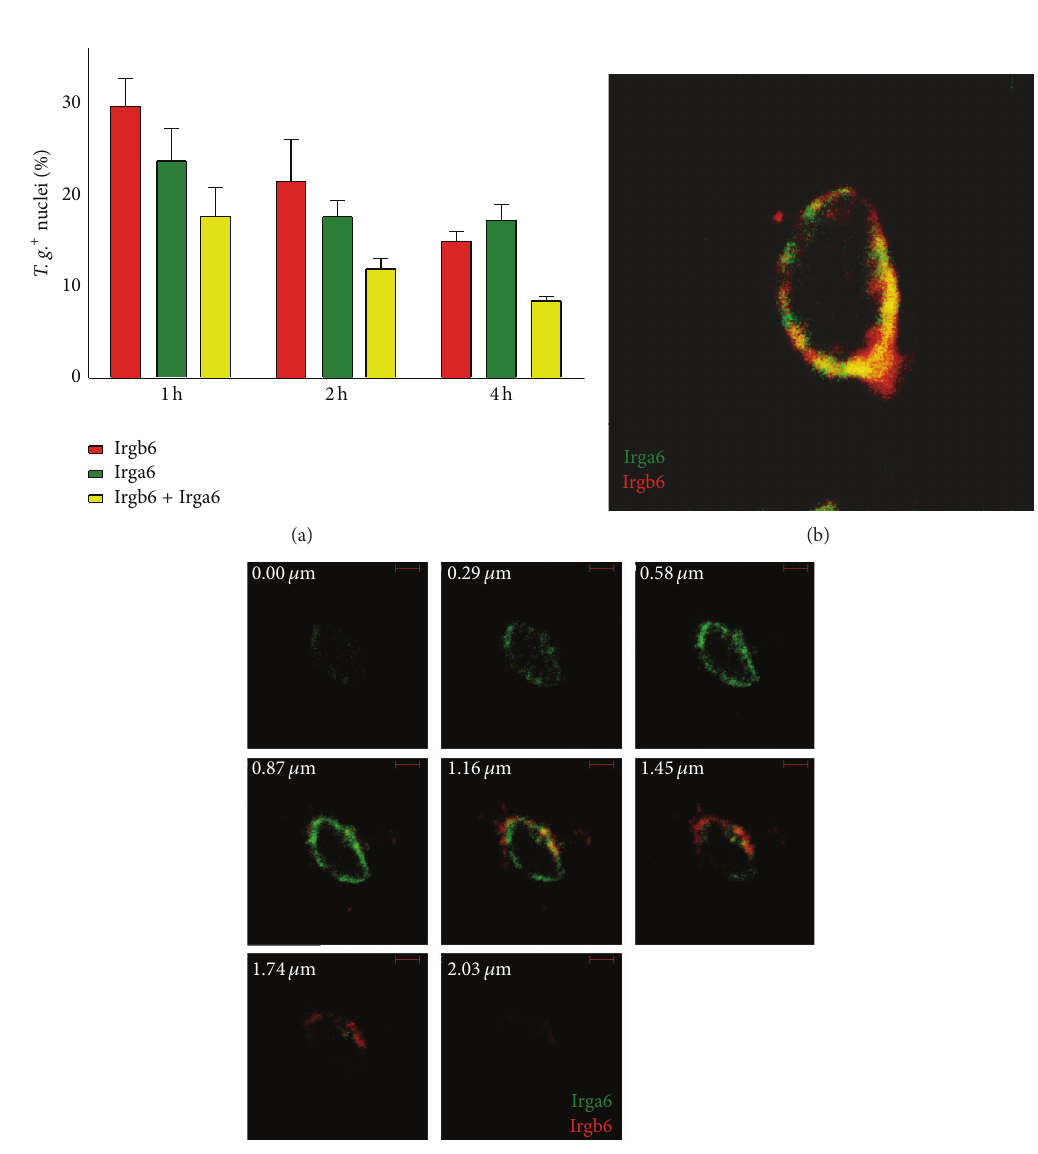
Figure 3: Kinetics and localisation of Irga6 and Irgb6 at the PV of avirulent T. gondii . (a) Astrocytes were prestimulated with 100U/mL IFN 𝛾 , pulse-infected with ME49 (MOI: 10) for the indicated time points, and stained for Irga6 and Irgb6. PVs were identified via nucleus staining of tachyzoites with DAPI. Quantitative analysis for both IRGs was performed in three independent experiments at the indicated time points mean ± SEM. Red: Irgb6 + PV, and green: Irga6 + PV, yellow: PV double positive for both analyzed IRGs. ((b), (c)) Astrocytes were prestimulated with IFN 𝛾 (100U/mL), pulse-infected with ME49 for 2 h, stained for Irga6 (green) and Irgb6 (red), and analyzed in a confocal microscope. The experiments were repeated three times with comparable results. (b) Representative image of a parasite in a longitudinal section. (c) Representative layered images through a PV with a distance of 0.29 𝜇 m between each layer. Note the different distribution of the two IRGs at the PV while scanning through different layers. Bars: 2 𝜇